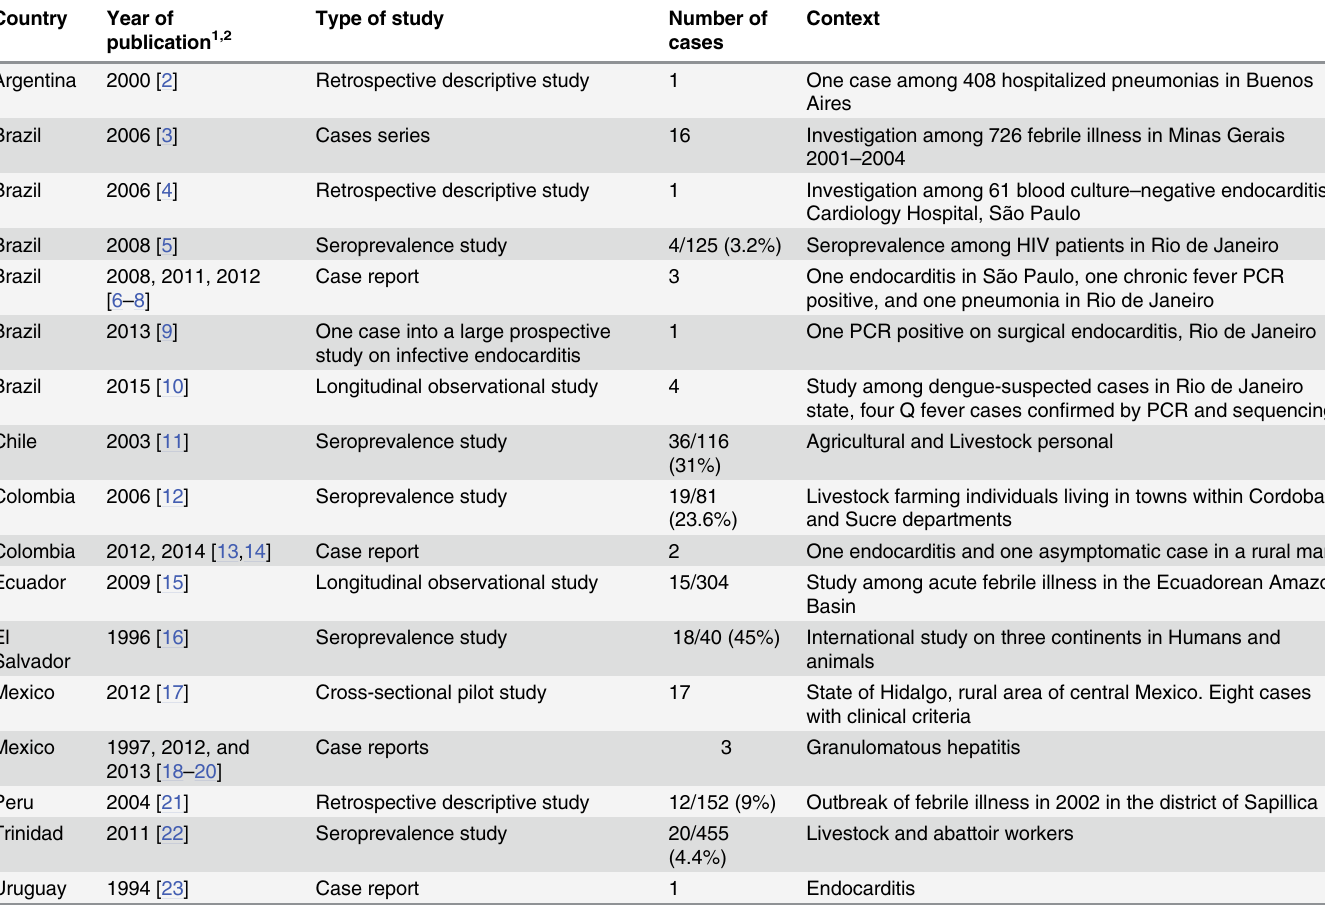
Table 1. Review of the English, Portuguese, Spanish, and French scientific literature (using the terms “ Q fever ” and “ Coxiella burnetii ” in MED- LINE and Google) among Q fever in South and Central America (except the Caribbean) since 1990, except French